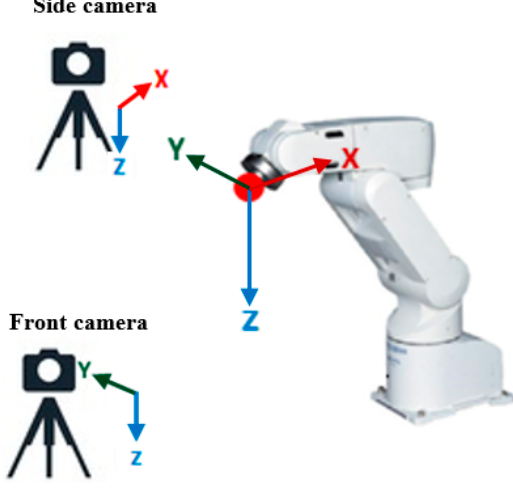
Figure 9. Camera setups in the experiment.